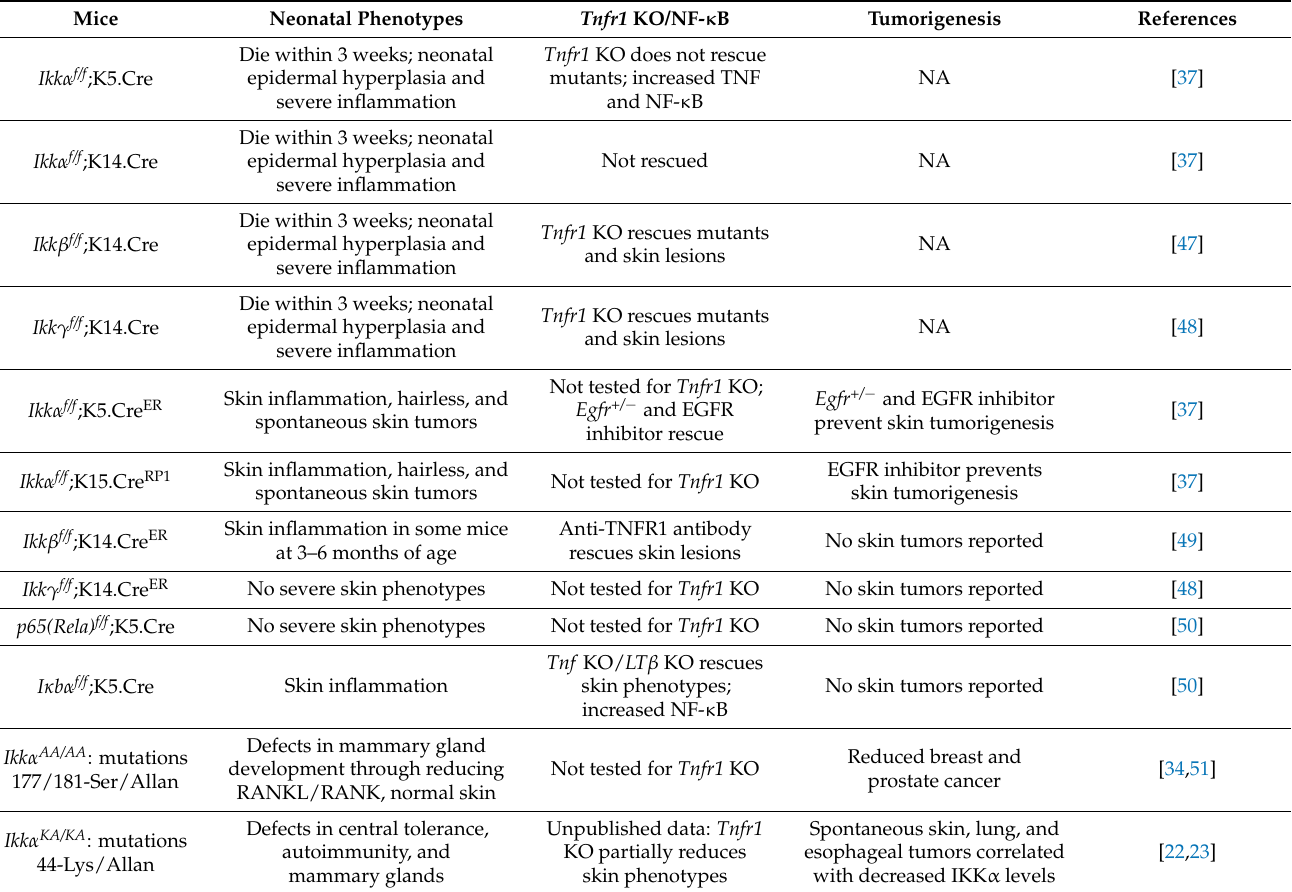
Table 2. Comparison of physiological activities and tumorigenesis in mice lacking IKK/NF-kB in specific tissues. Mice Neonatal Phenotypes Tnfr1 KO/NF- κ B